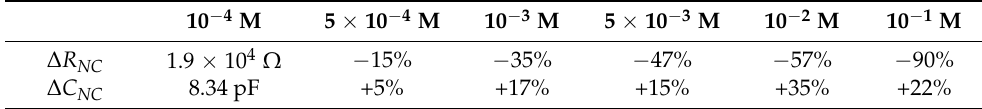
Figure 5. ( A ) Impedance measurements of the nitrocellulose (NC) membrane with isolating backing as seen by the parallel-plate setup. The NC membrane is saturated with saline solutions of different molar concentrations, modelling the dielectric properties of real water samples. A significant decrease in the impedance modulus results from an increase of the ionic strength, expressed as a drop in the membrane resistance R NC . ( B ) The impedance phase evolution over 10 kHz–1 MHz highlights the contribution of both R NC and C NC to the impedance of the system. As the resistive peak in the phase shifts with the ionic strength, the system is, therefore, sensitive to saline electrolyte through both R NC and C NC changes. ( C ) Dielectric relative permittivity of the system as seen by the parallel-plate setup, with different diluted salt solutions in the nitrocellulose membrane. Number of samples: 12 from two independent experiments. Shaded area surrounding the measurements curves: standard deviation ( σ ). σ smaller than the measurement line thickness if not visible on the graph. Table 2. Monitoring of the nitrocellulose membrane resistance R NC and capacitance C NC , respectively showing consecutive relative decreases and increments with the concentration of the NaCl solutions used to model different types of water samples through their conductivities. The parallel-plate setup is more sensitive to R NC , but is still responsive to capacitance changes of the